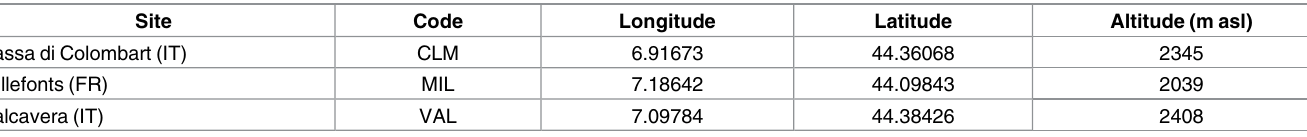
Table 1. Details of the sampling